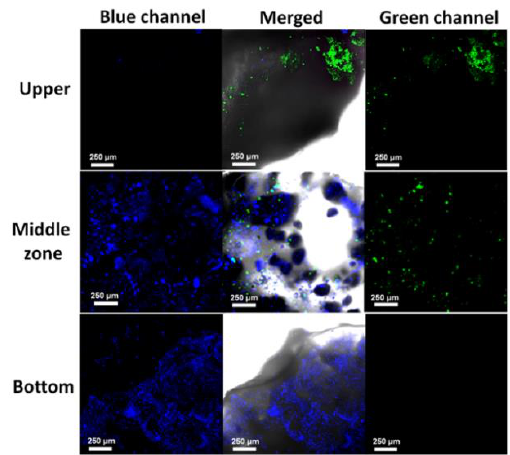
Figure 8. Confocal microscopy images of live stained hACs (Vibrant staining observed in the green channel) and hOBs (Höesch staining observed in the blue channel) were co-cultured on the biomimetic scaffolds after 14 days. Merge images showing the upper cartilaginous mimicking zone mainly colonized by hACs, Middle Interface zone colonized by both hOBs and hACs calcified bottom zone colonized by hOBs.